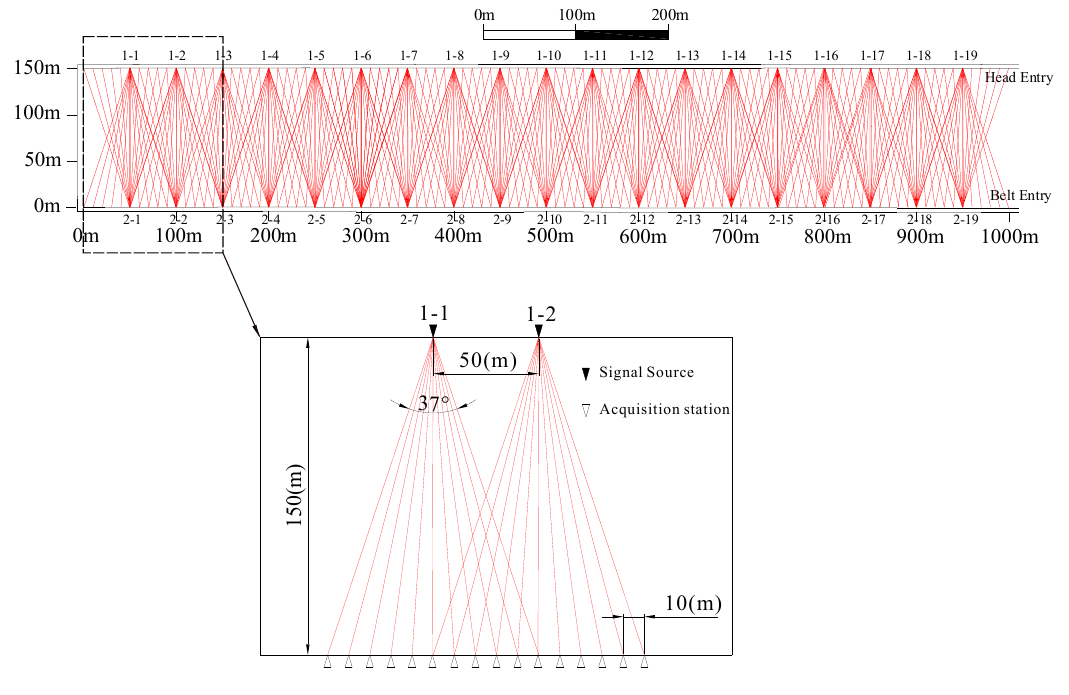
Figure 9. Layout of the observing systems.